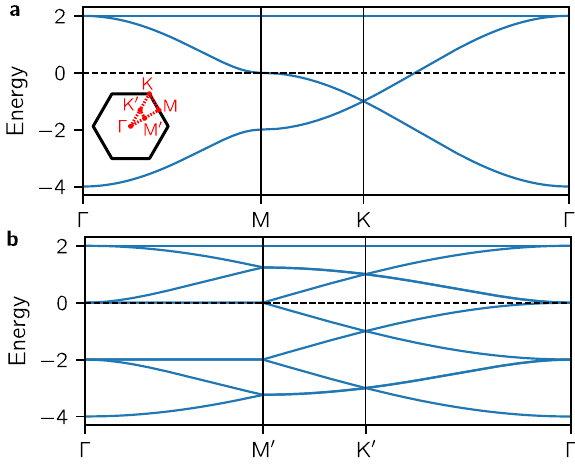
Fig. 1 Band structure. Metallic band structure along the high- symmetry path a . Γ -M-K- Γ for the kagome lattice, and b . Γ -M 0 -K 0 - Γ for the 2 × 2 kagome superlattice, for the tight-binding model with uniform nearest-neighbor hopping ( t i , j = − 1) and ϵ i = 0. The dashed horizontal line indicates the Fermi energy at 5/12 fi lling. The inset of a shows the hexagonal Brillouin zone of the kagome lattice (in black) together with the location of the high-symmetry points and the chosen path (in